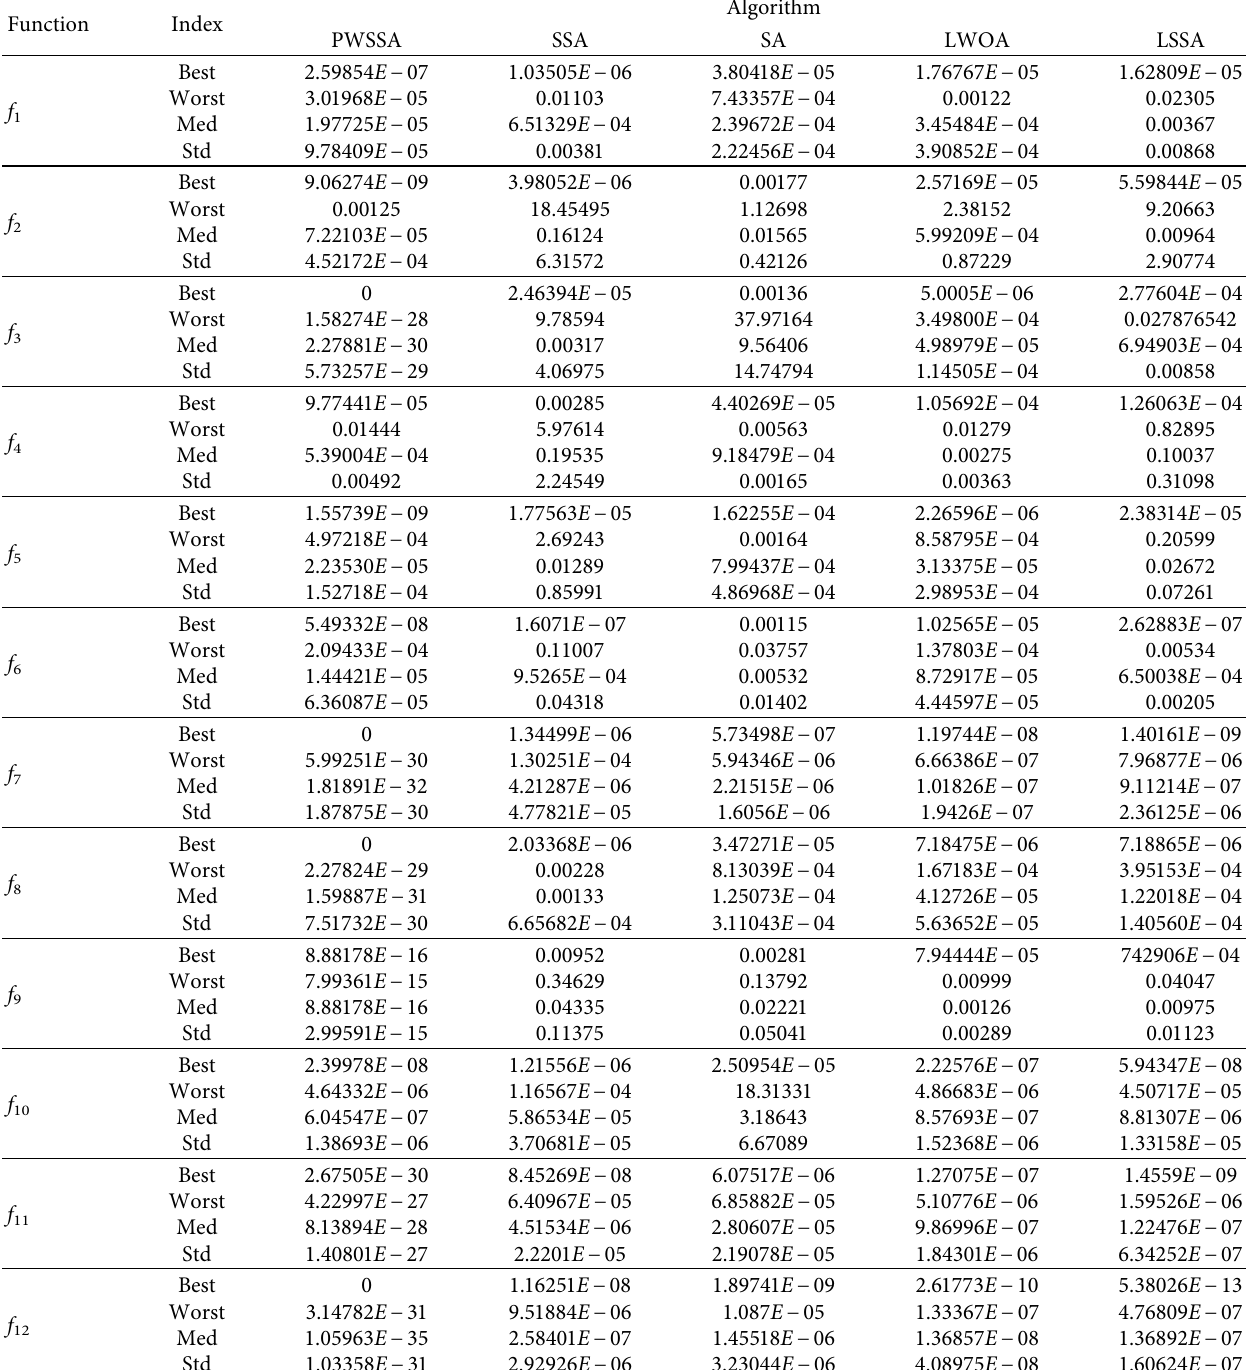
Table 2: Comparison of testing results for functions ( D �